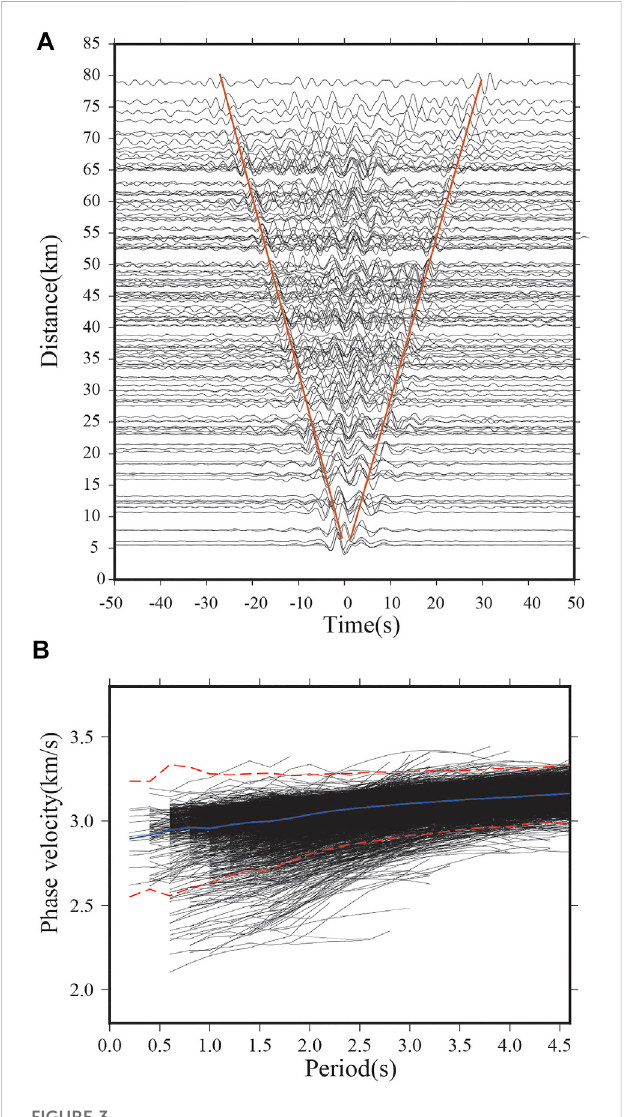
FIGURE 3 (A) Theplotofcross-correlationfunctionsofstationHS136withthe period-band of 0.5 – 10 s (orange lines represent the average velocity with 2.6 km/s) (B) All phase velocity dispersion curves from 0.8 to 4.6 s obtained after quality control. The blue line shows the mean Rayleigh wave phase velocity; two red lines give the lower and upper boundaries of ±2.5 times the standard deviation.